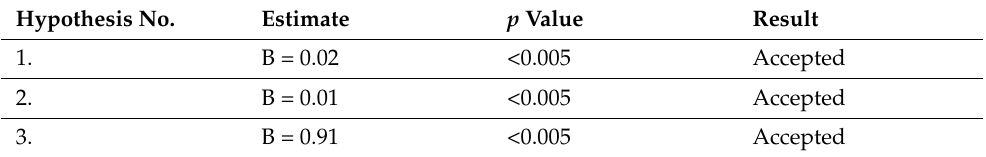
Table 7. Results of hypothesis testing.